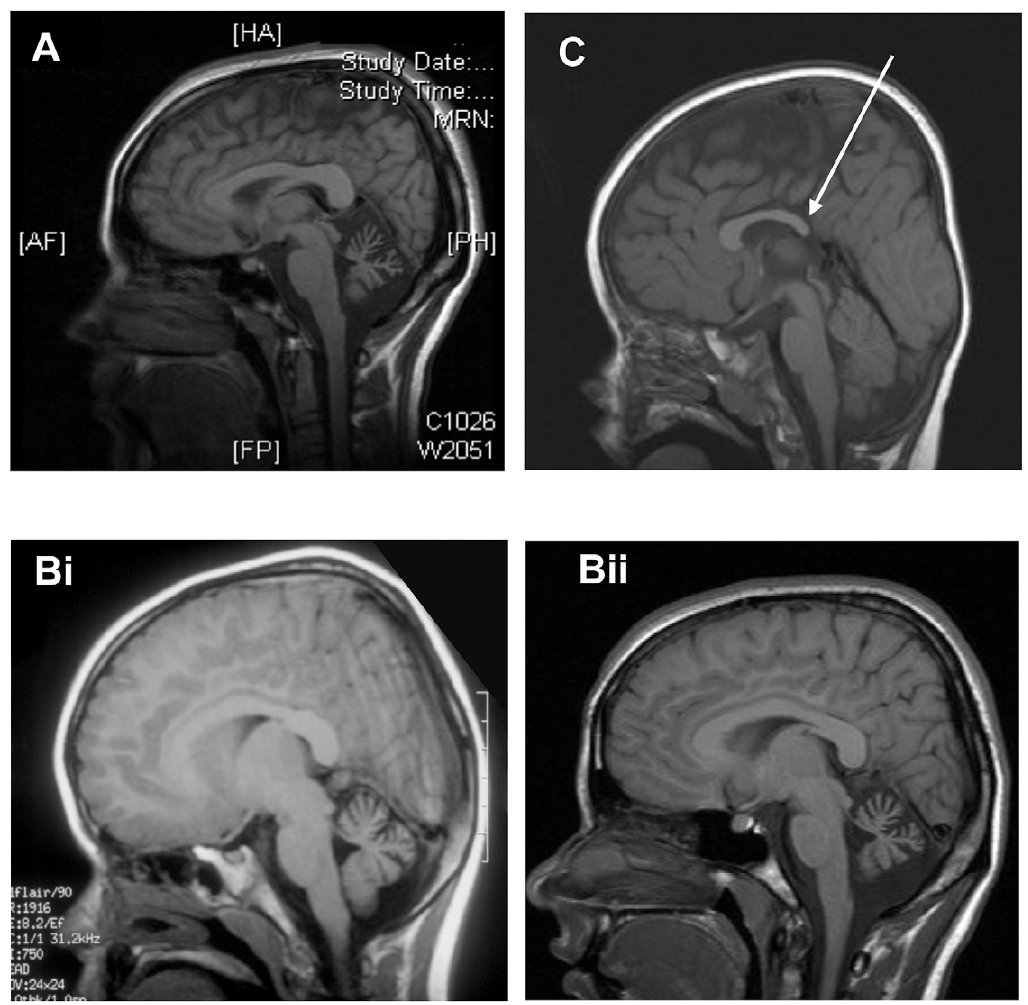
Figure 2. Neuroimaging of patients. A. Sagittal T1w MRI in subject V1 age 21 demonstrating clear cerebellar atrophy. B. Sagittal T1w MRI in subject V2 at age 6. Sagittal T1w MRI in subject V2 age 16 shows clear atrophy of the cerebellum. C. Sagittal T1w MRI in subject V3 showing hypoplasia of posterior corpus callosum (white arrow).